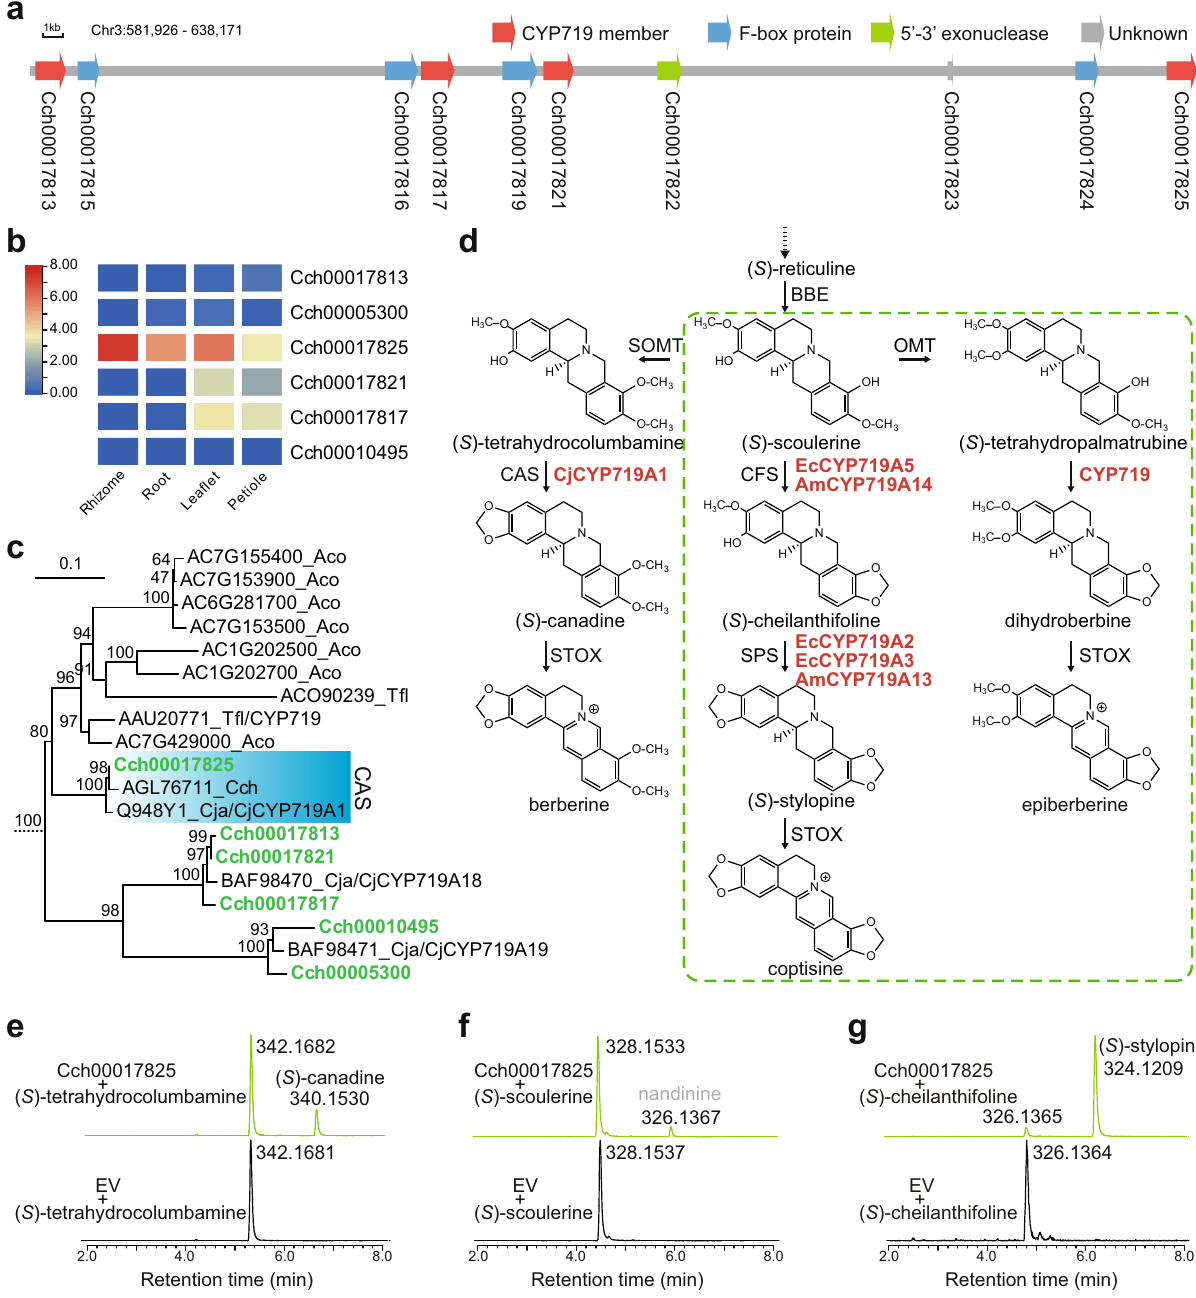
Fig. 4 Evolution of CYP719 members in Coptis chinensis . a A gene cluster in relation to tandem duplication of CYP719 genes on chromosome 3. b Tissue- speci fi c expression of CYP719 genes identi fi ed in C. chinensis . The expression values were log2 transformed. c The Ranunculaceae subclade of the CYP719 gene tree. See Supplementary Fig. 27 for a full version of the CYP719 gene tree. Gene sequences from the present study are marked in green. Aco: Aquilegia coerulea , T fl : Thalictrum fl avum , Cch: C. chinensis , Cja: C. japonica . d Putative branch pathways for the biosynthesis of berberine, coptisine and epiberberine. The box with the green dashed line borders indicates pathways proposed from the results of other plant species (coptisine) or suspected from the chemical structure per se (epiberberine). See Supplementary Data 5 for the abbreviations of the enzymes. The known CYP719 enzymes are denoted with a pre fi x of species name. Cj: C. japonica , Ec: Eschscholzia californica , Am: Argemone mexicana . e – g Extracted ion chromatograms showing the in vitro catalytic activity of Cch00017825 with three different substrates. In each case, enzyme-mediated activity is indicated by the green chromatograms, while those for the empty vector (EV) negative control assays are in black. The speculated product of nandinine was marked in gray. Source data underlying Fig. 4b are provided as a Source Data fi